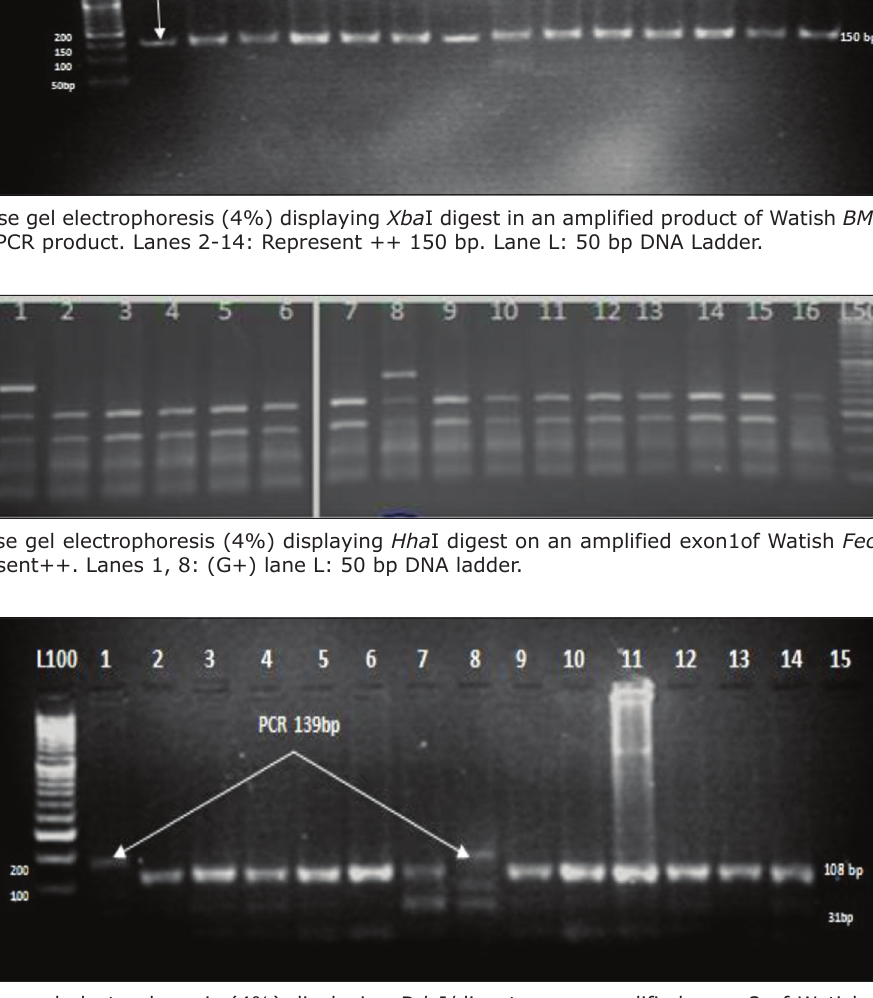
Figure-7: Agarose gel electrophoresis (4%) displaying Dde I/digest on an amplified exon 2 of Watish Fec G -G8. Lanes 1, 8: Polymerase chain reaction product (139 bp). Lane 2-7, 9-15: Represent ++(108-31) bp. Lane L: 100 bp DNA